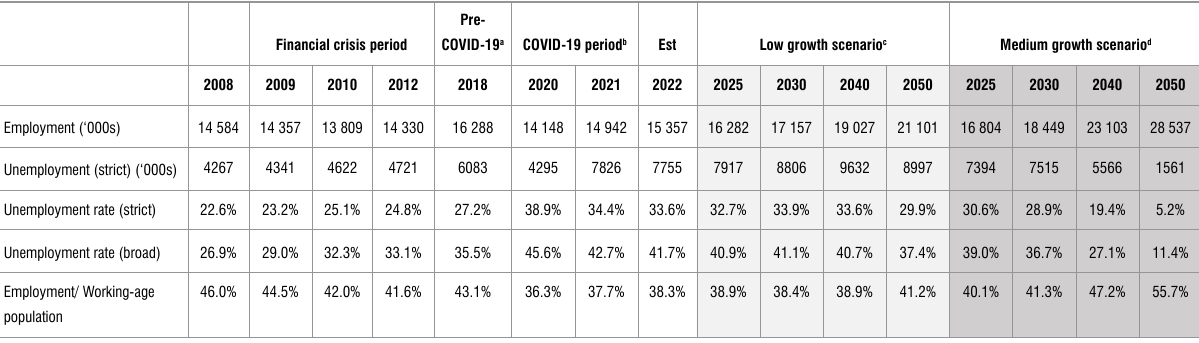
Financial crisis